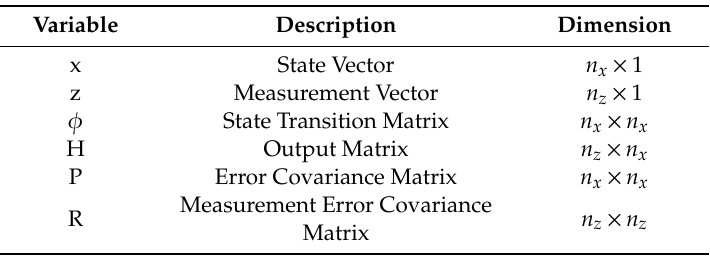
Table 1. Dimension of